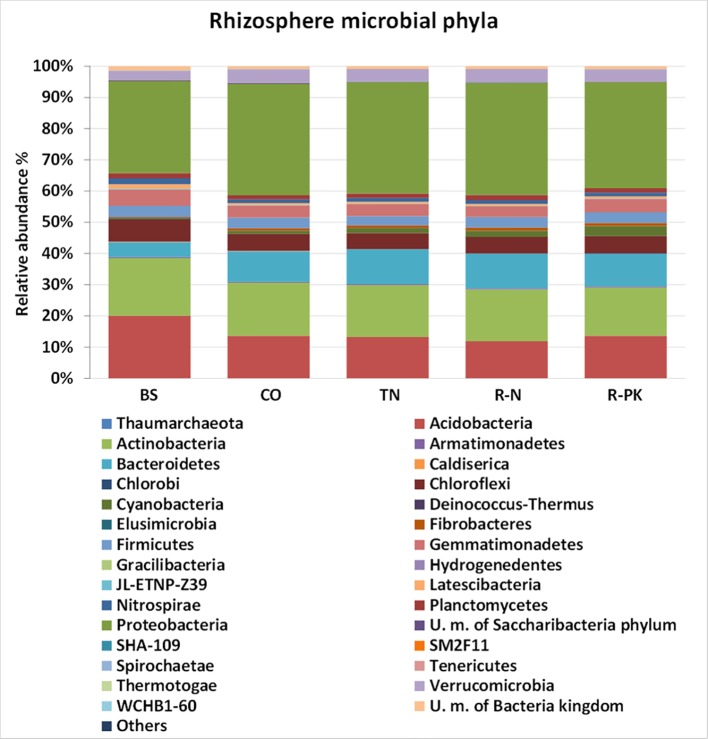
Microbial community composition (%; n = 3 ± s.e.) at the phylum level based on 16S rDNA reads in bulk soil (BS) and the rhizosphere of Triticum aestivum inoculated with biofertilizers (TN, TripleN; R-N, Rhizosum N; R-PK, Rhizosum PK) and noninoculated controls (CO) (Newman-Keuls test, P ≤ 0.05). Only taxa >0.6% are shown.